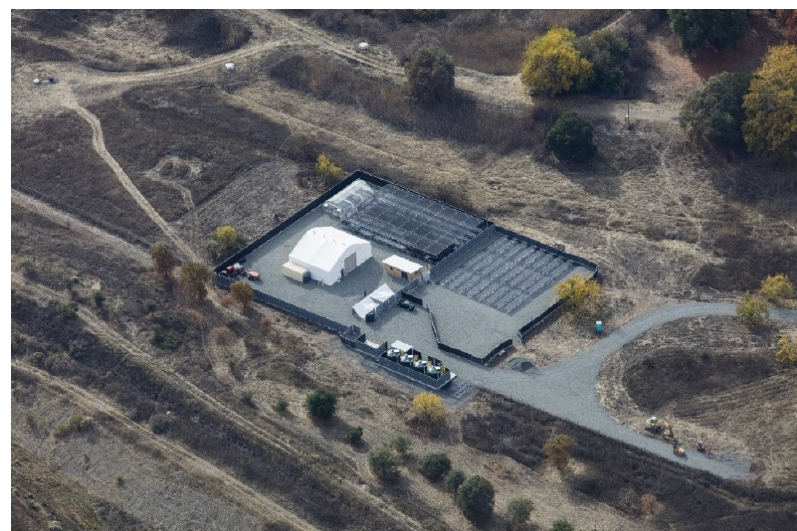
Figure 2. The SFPUC Sunol Native Plant Nursery in Alameda County. The design, layout, and operations of the facility incorporate strict phytosanitary measures to prevent Phytophthora . Credit: SFPUC.